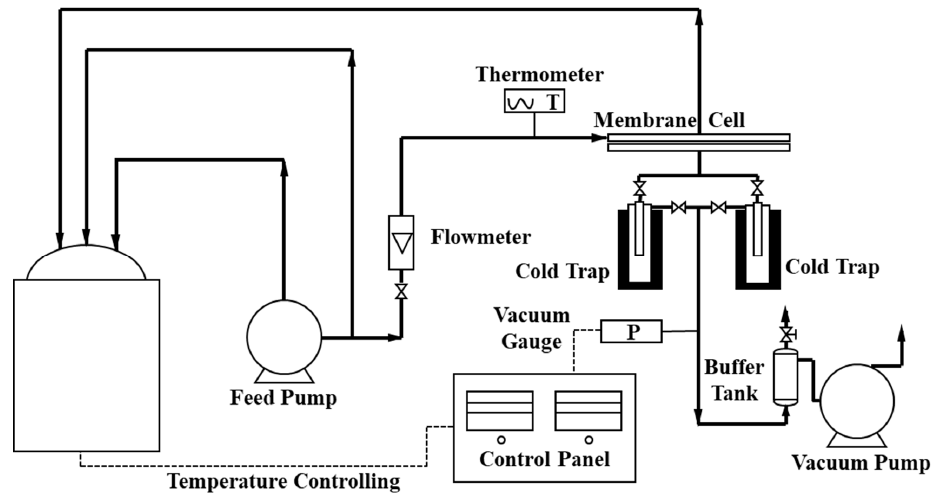
Figure 2. Flow diagram of the homemade PV device.